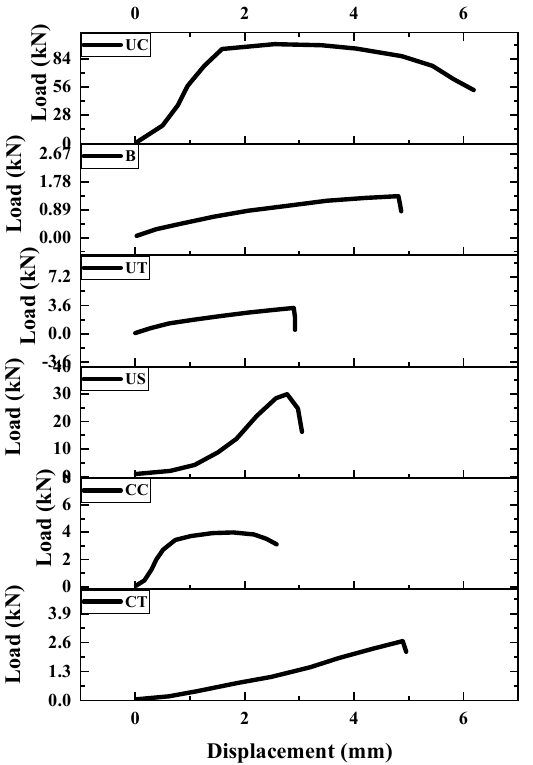
Figure 3. Typical load-displacement curve of the specimen.